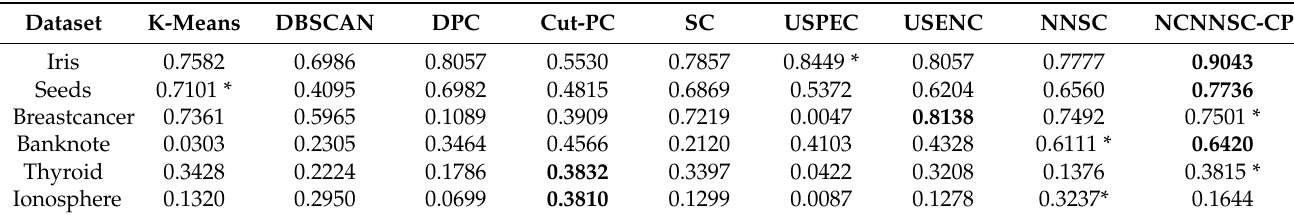
Table 6. The Normalized Mutual Information (NMI) of the nine algorithms on six UCI